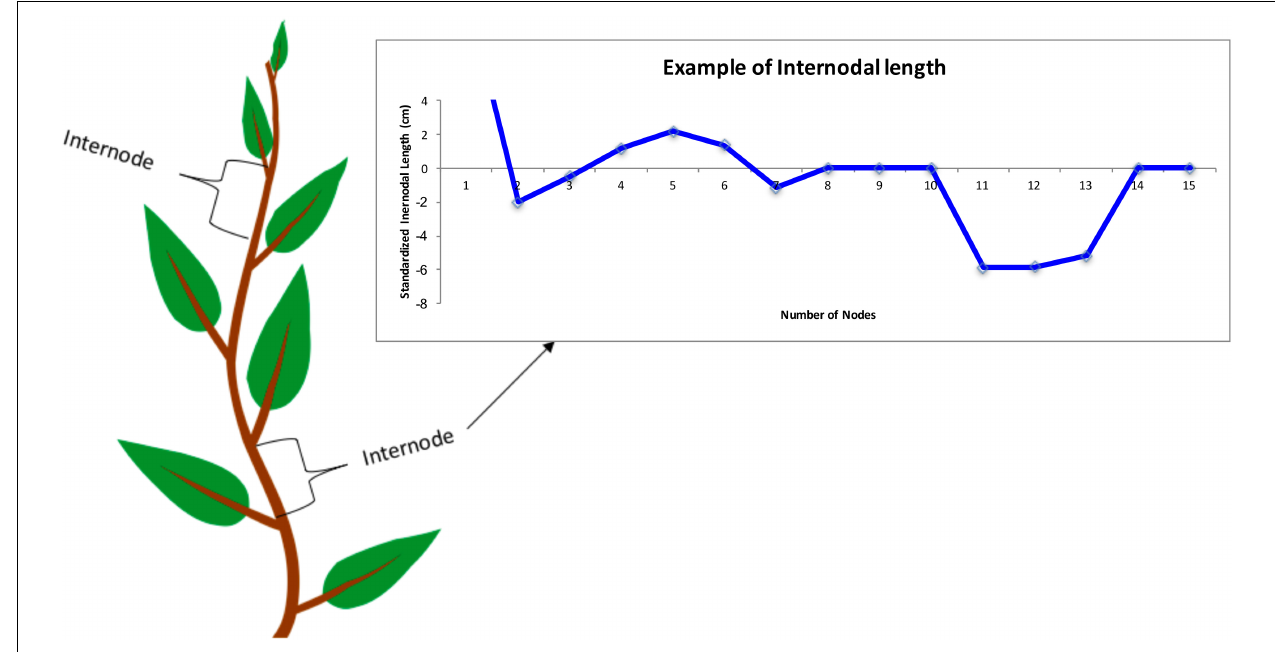
FIGURE 2 | An example of measuring a node on a branch and then analyzing the internodal length.